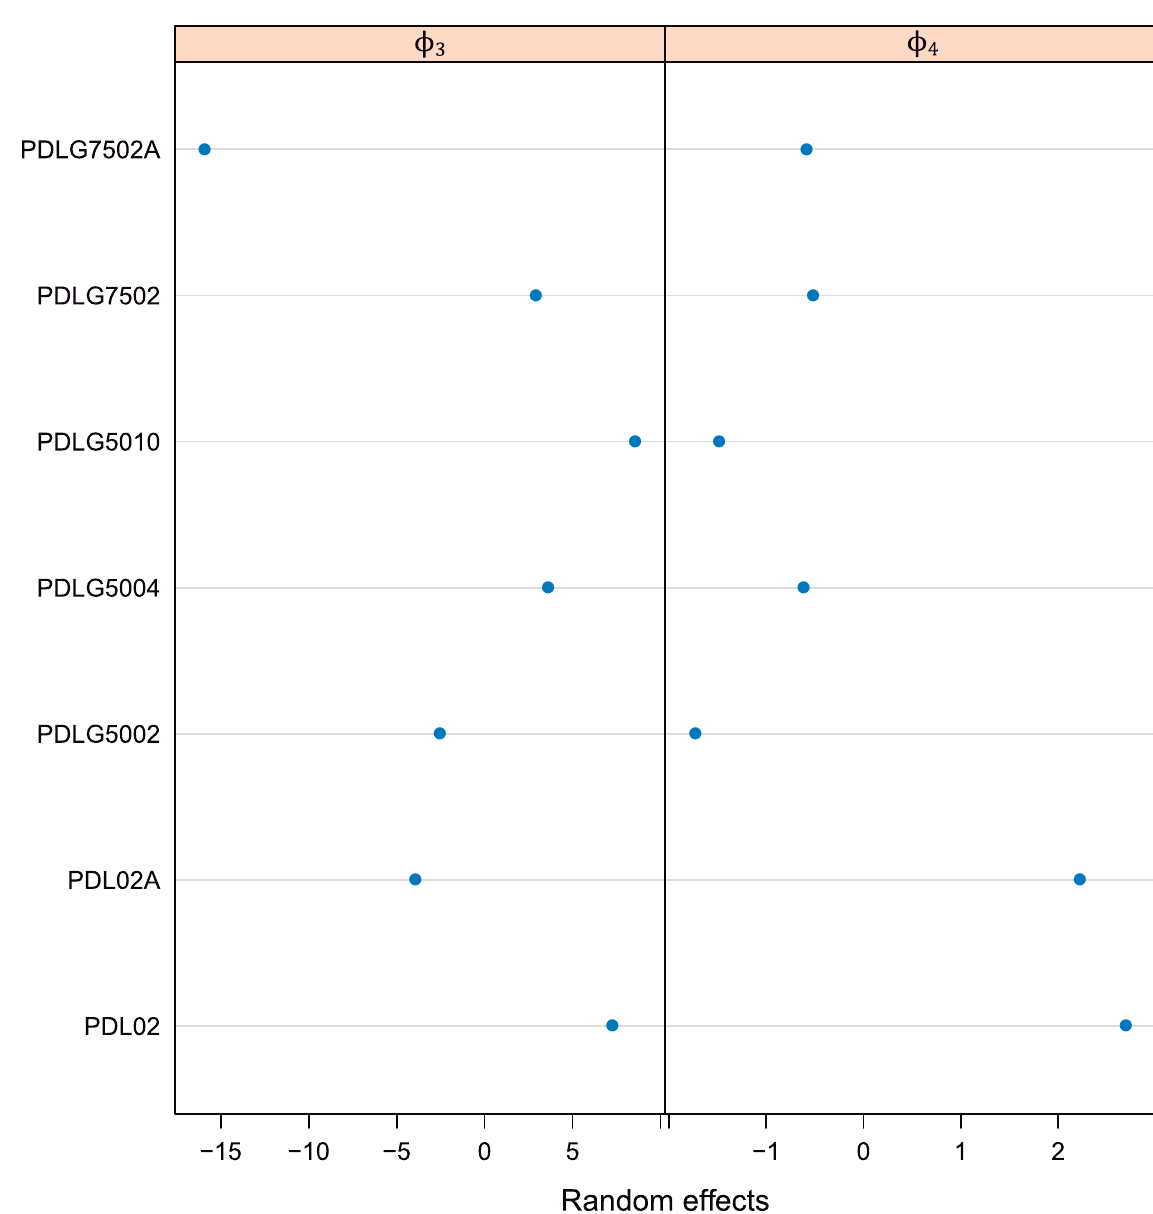
Fig 14. Random effects, b 3 i and b 4 i of ϕ 3 and ϕ 4 parameters corresponding to the nonlinear mixed-effect model of pH vs. time and PDLGA formulation.